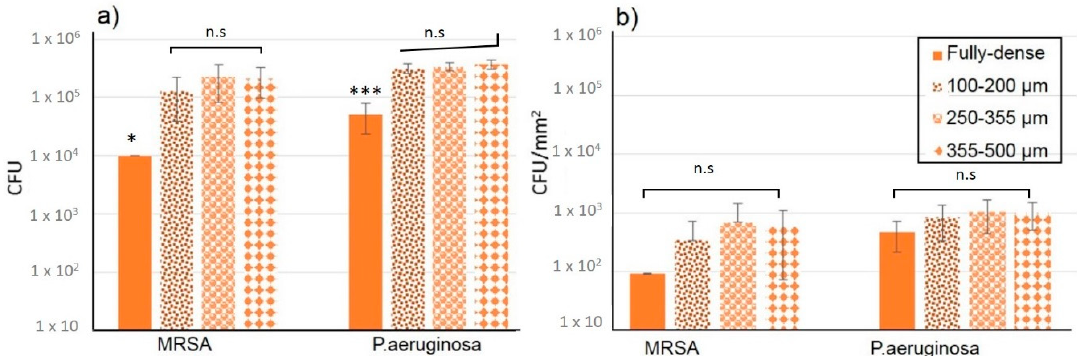
Figure 8. Bacterial behavior for different MRSA and P. aeruginosa bacteria concentrations on titanium substrates: ( a ) Absolute values and ( b ) normalized values per area. Note: Data are expressed as the mean ± standard error of the mean. * P < 0.05, ** P < 0.01 (compared to all others).